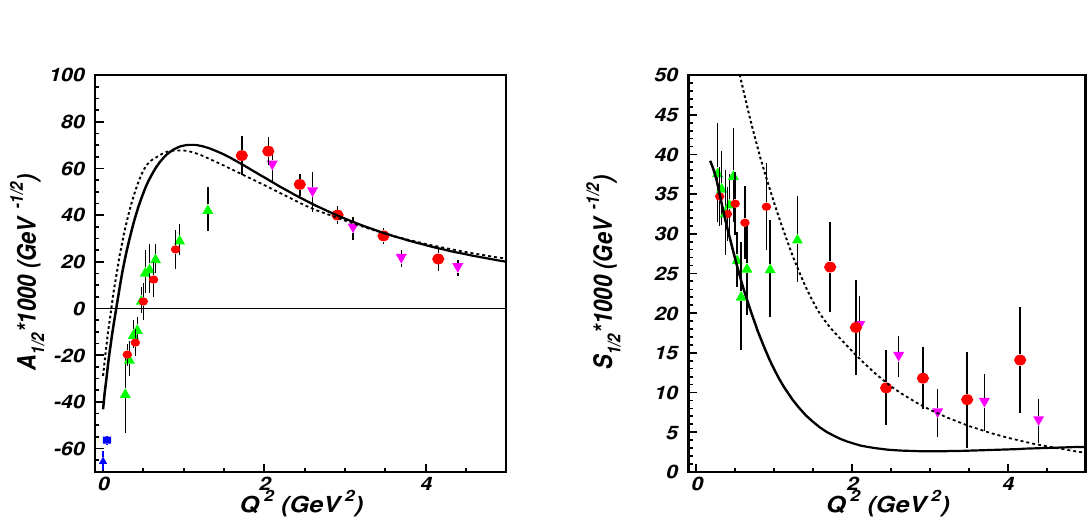
Figure 3. (Color online) CLAS results on the N (1440)1 / 2 + electrocouplings from analysis of the recent data on π + π − p electropro- duction [18, 19] (magenta filled triangles), from the analyses of N π electroproduction [32] (red filled circles), and from the previous CLAS data on π + π − p electroproduction [9, 21] (green filled circles). The results at the photon point are taken from the PDG [29] (blue filled triangle) and from analysis of the CLAS N π photoproduction data [33] (blue filled square) The N (1440)1 / 2 + electrocouplings computed within the DSE [10] are shown by the solid lines. The results from the novel light front quark model [6, 11] are shown by the dashed lines.